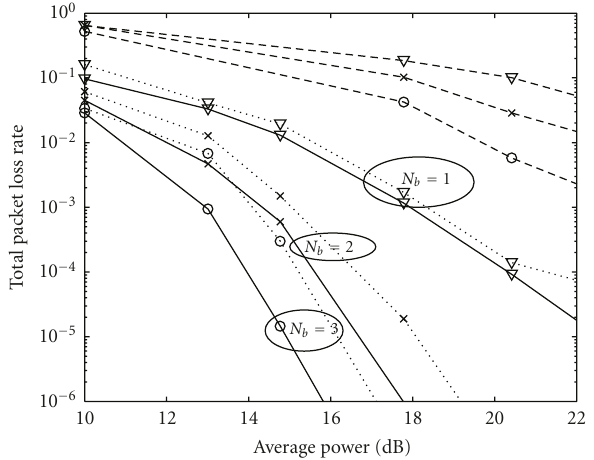
Figure 5: Variation of average packet loss with SNR for bu ff er length L = 2. The performance of the scheme with no TBIR (dashed lines), statistical TBIR (dotted lines), and one bit of instantaneous TBIR (solid lines) is shown.